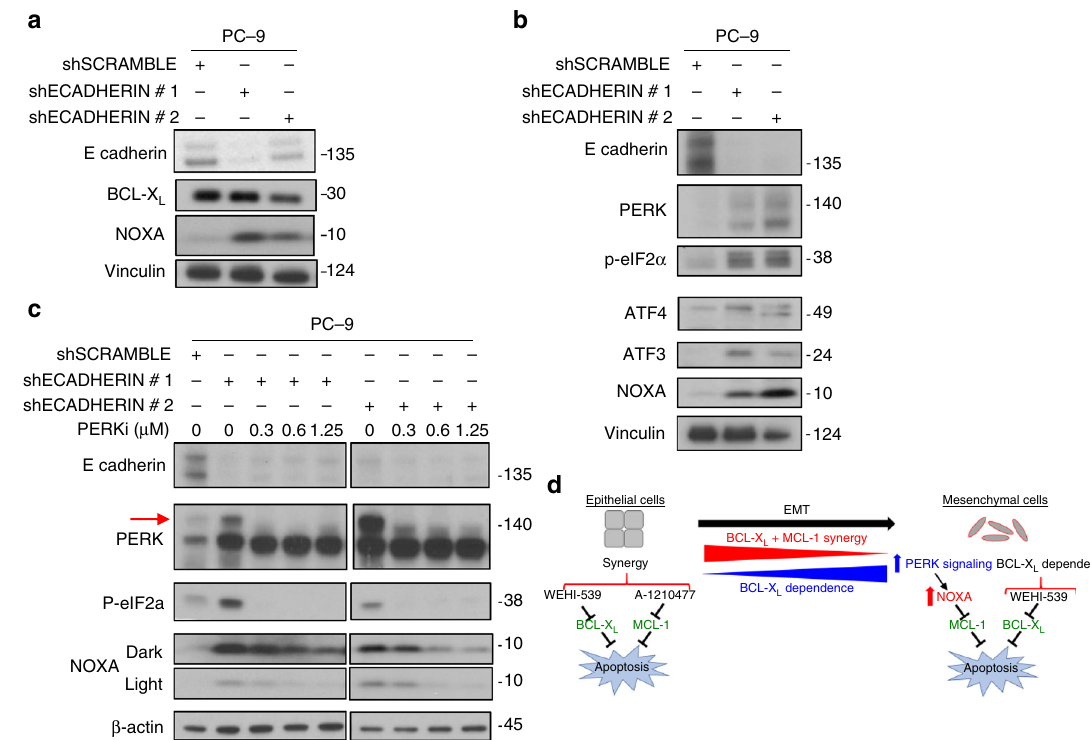
Fig. 5 EMT induces NOXA expression and BCL-X L dependence via the PERK pathway. a Western blot data of PC-9 cells transduced with shECADERIN to induce an EMT. Expression levels of E-CADERIN, BCL-X L , NOXA, and Vinculin are compared via western blotting in cells after a 3-day selection in puromycin. b Expression levels of PERK signaling markers in cells forced to undergo EMT. PC-9 cells were transduced with shECADERIN and after 3 days in puromycin, markers of the PERK signaling pathway (PERK, p-eIF2 α , ATF4, ATF3, NOXA) were compared using western blotting. c Blocking PERK signaling prevents EMT- induced NOXA expression. PC-9 cells were transduced with shECADHERIN or control and immediately incubated in the indicated concentrations of the PERK inhibitor (PERKi) GSK2606414 for the remainder of the 3 days in puromycin. Loss of the PERK autophosphorylation band (red arrow) indicates that PERKi is effective at the concentrations used. d Model: Epithelial cells tend to exhibit a synergistic co-dependence on BCL-X L + MCL-1, and therefore respond best to a combination of WEHI-539 and A-1210477. As cells become more mesenchymal like, either initially or via forcing an EMT, there is an increase in PERK signaling and PERK-dependent NOXA expression. This higher expression of NOXA renders cells more dependent on BCL-X L alone because the relatively higher amounts of NOXA neutralize MCL-1 in these cells. As such, the more mesenchymal cells are more responsive to WEHI-539 used as a single